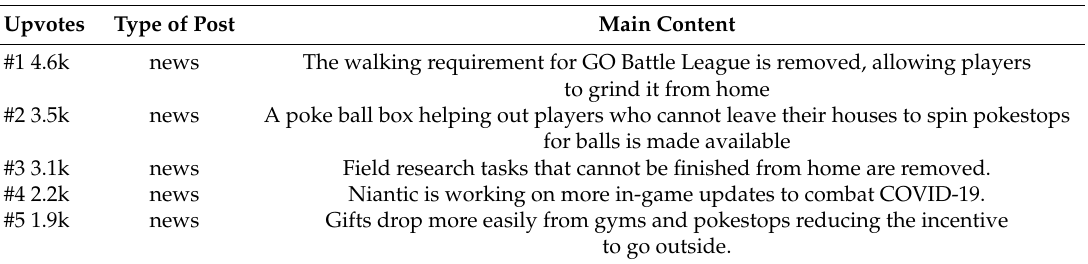
Table 5. Top 5 most upvoted COVID related comments on /r/SilphRoad during 4 March–3 April